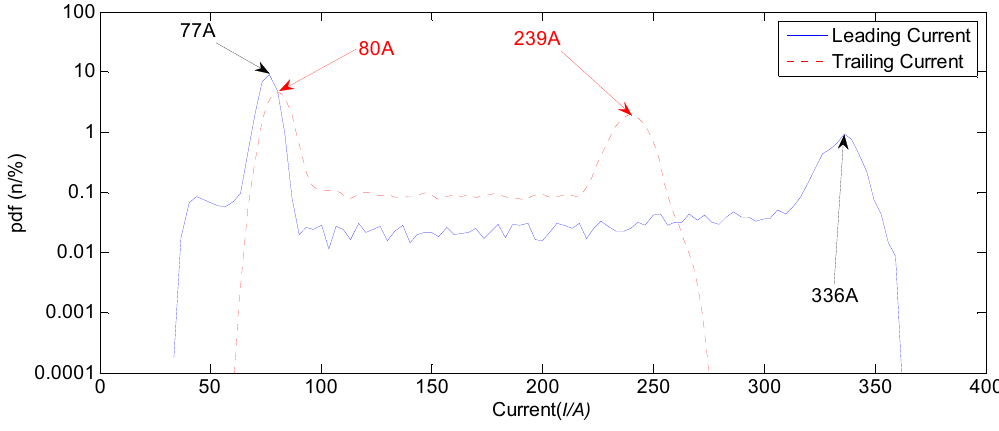
Figure 9. Pdf figure of experiment 13.